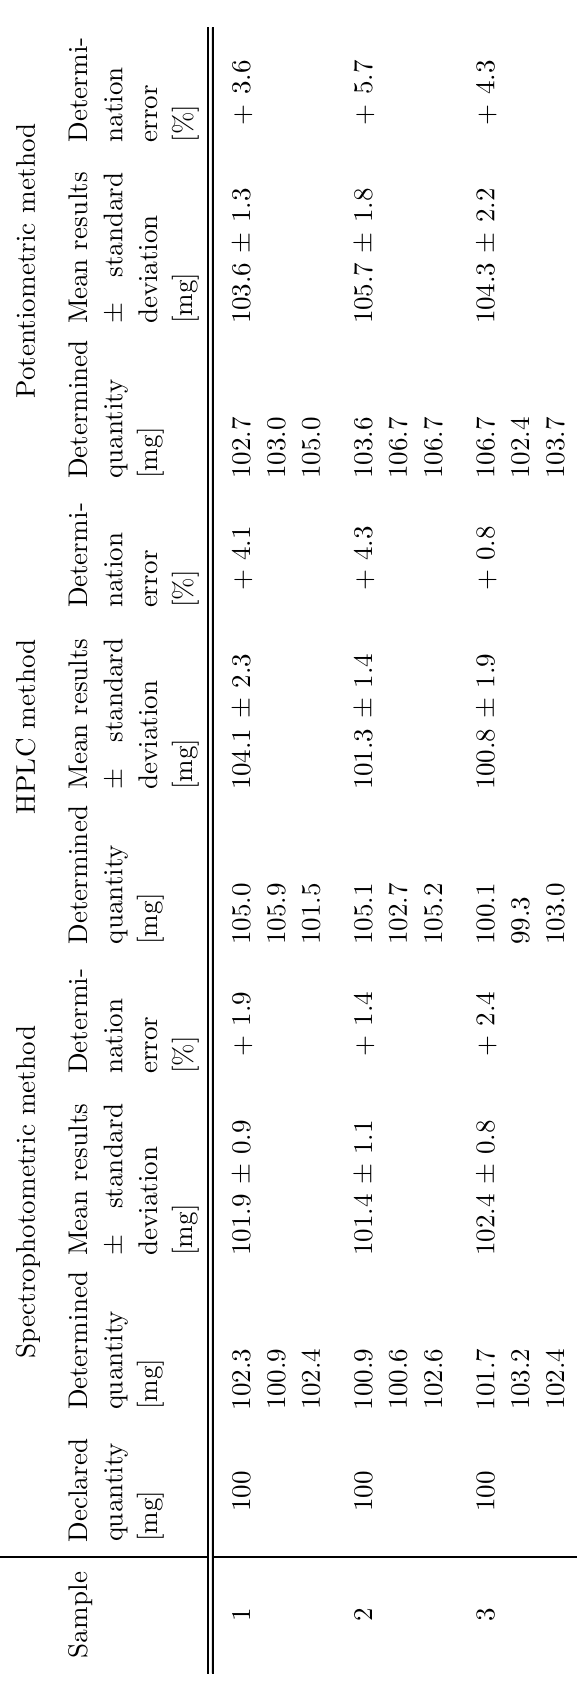
Table 3 Results of labetalol hydrochloride determination (Trandate